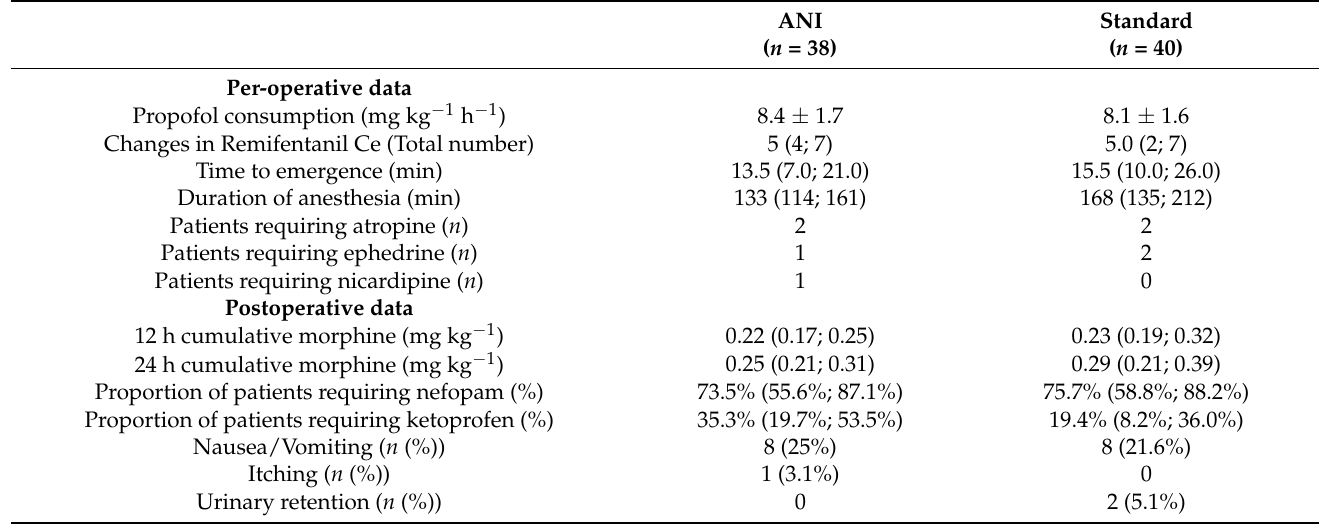
Table 2. Quality of anesthesia and postoperative analgesia. Data are presented as Number ( n ), mean ± SD or median (95% confidence